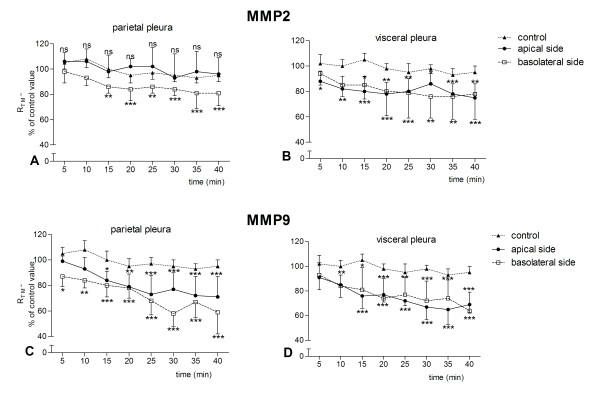
Effect of 0.1 ng/ml MMP2 and MMP9 on the transmesothelial resistance (RTM) of sheep pleura. A time-dependent decrease in transmesothelial resistance (RTM) occurred at both parietal and visceral pleura and on both the apical and basolateral side. For MMP2 the decrease on the apical side of parietal pleura is not significant. Data are given as mean ± SD (n = 6). ns: non-significant, * p < 0.05, ** p < 0.001 and *** p < 0.0001 compared to control RTM (ANOVA test with Dunett post-test).